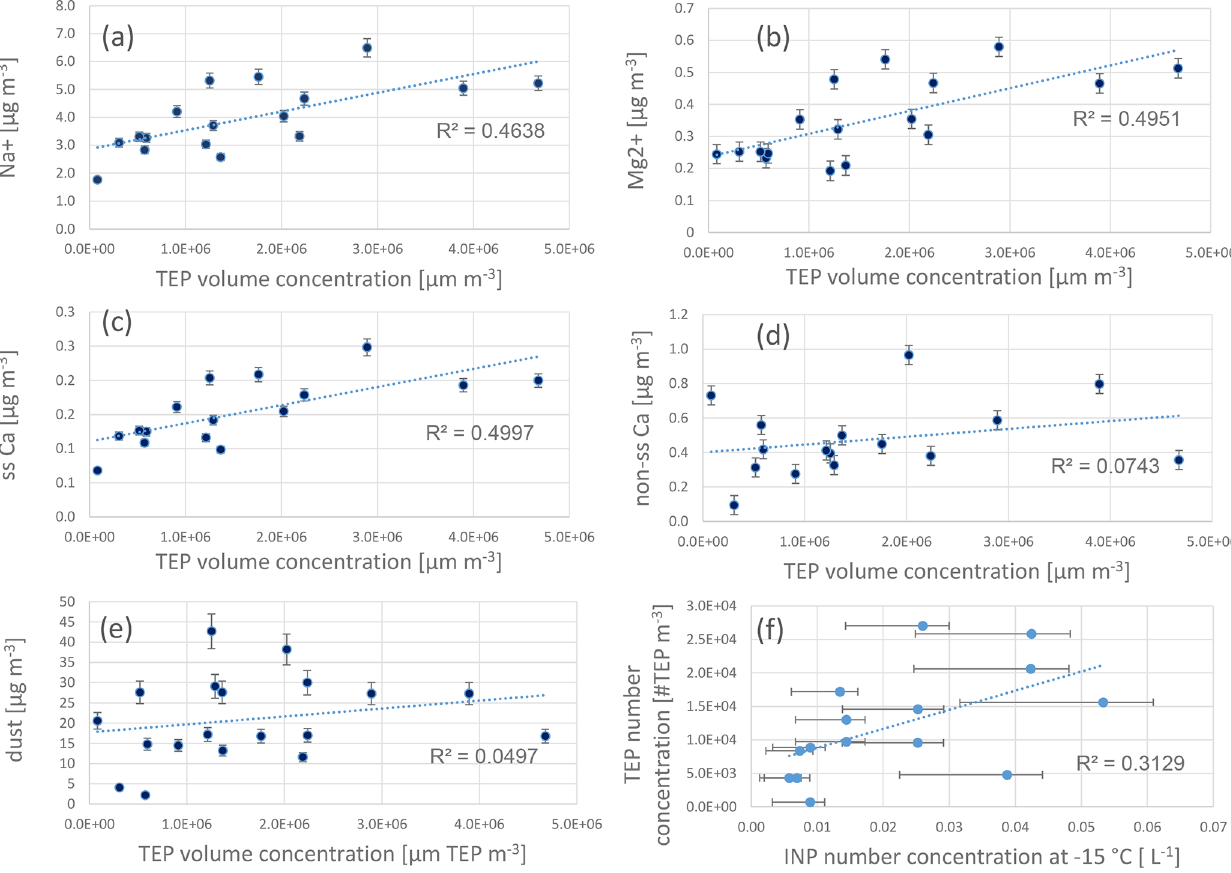
Figure 7. Correlations of transparent exopolymer particle (TEP) volume concentrations (size range: 5–10µm) with chemical parameters (inorganic constituents PM 10 ) and dust (PM 10 ), as well as correlation of TEP number concentration and ice nucleating particle (INP) number concentrations. Inorganic constituents were measured with ion chromatography and dust concentrations were derived from PM 10 concentrations as reported elsewhere (Fomba et al., 2013; van Pinxteren et al., 2020). Measurements of INP number concentrations and error bars are explained in Gong et al.